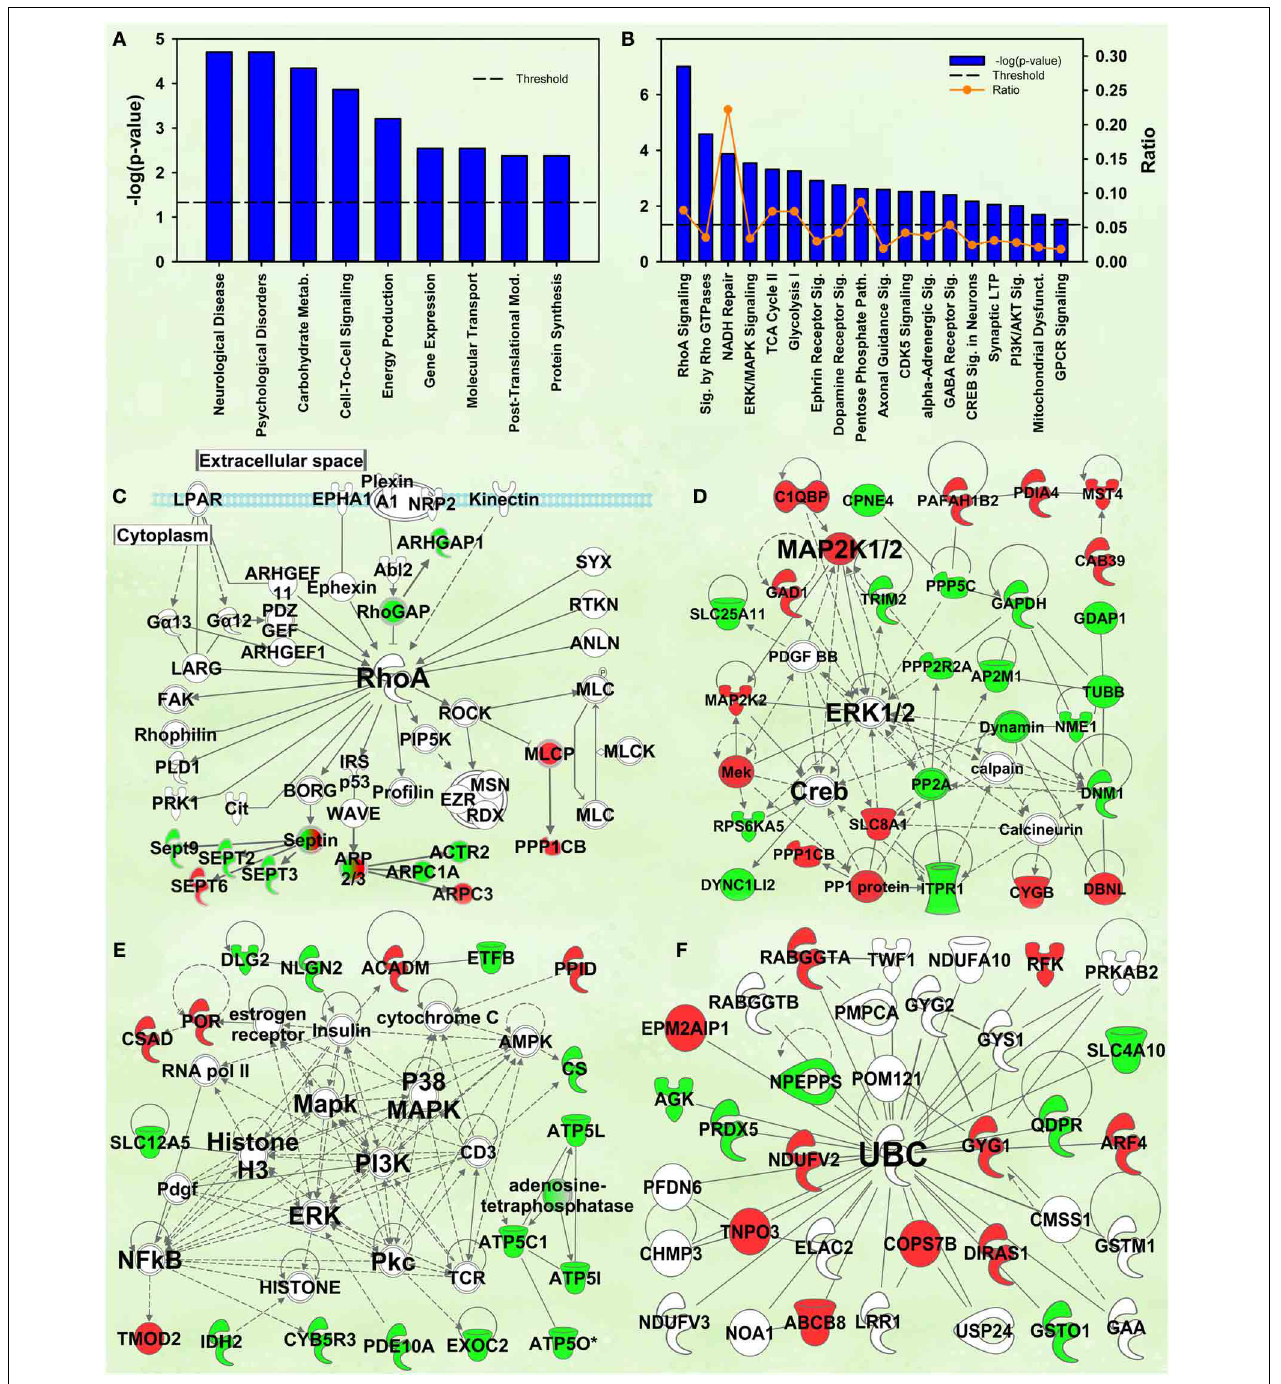
FIGURE 4 | IPA and GSEA findings for the Enrichment X Cocaine interaction. A complete list of results can be found in Supplementary Materials, as can a complete list of all proteins in each pathway. (A) A selection of significant biological functions and diseases, as determined by IPA. The y axis represents the − log( p ) value for each function/disease. (B) A selection of significant canonical pathways for Enrichment X Cocaine interaction, as determined by IPA. Orange line represents a ratio of regulated proteins to all proteins in the pathway. (C) RhoA signaling canonical pathway from IPA (from B ). Proteins with a